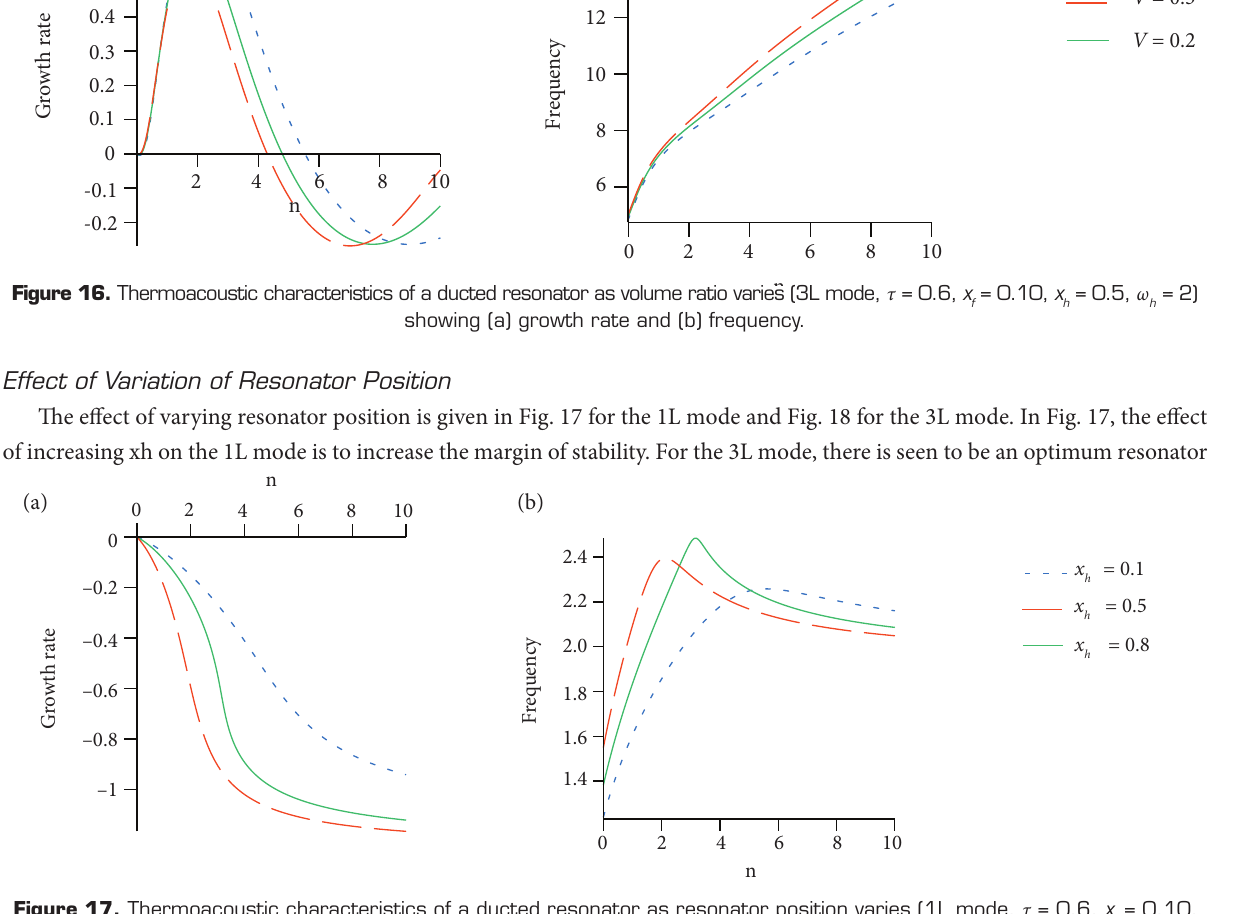
= 2) showing (a) growth rate and (b) frequency. V = 0.2, ω h